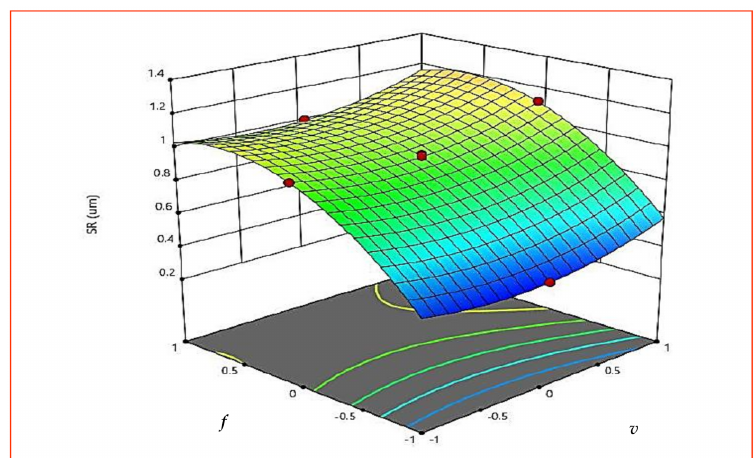
Figure 9. Response graph for SR .